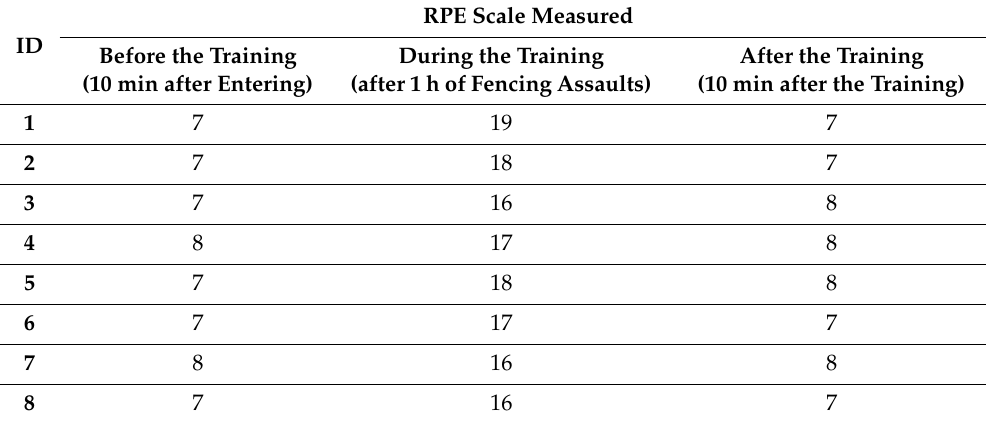
Table 5. Rate of perceived exertion (RPE) scale measured for all the athletes before, during and after the training (before the thermal images were